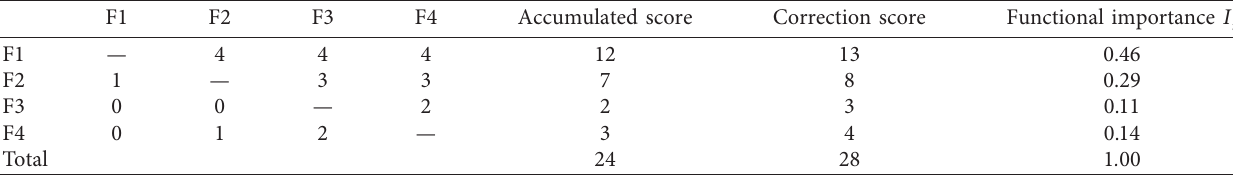
Table 2: Functional importance based on functional